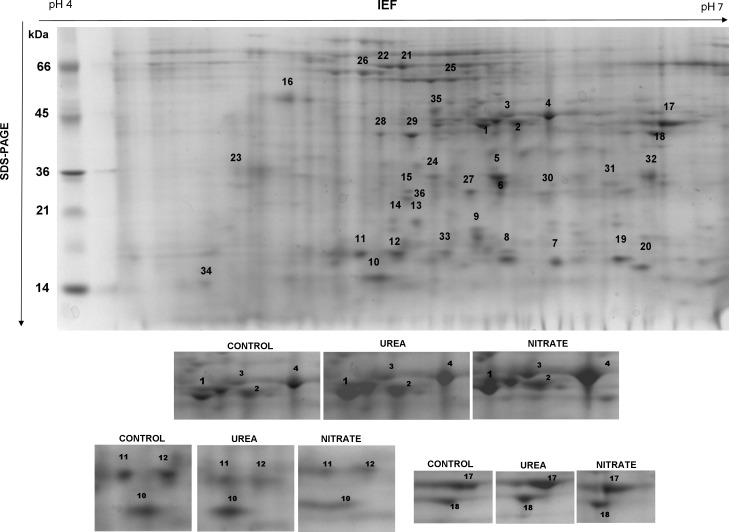
2D-GE pattern of total protein extracted from durum wheat (cv Achille) immature grains.Immature grains—derived from plants fertilized with urea (UREA) and calcium nitrate (NITRATE) at the rate of 150 kg N ha-1 plus unfertilized CONTROL—were sampled at DC75 phenological stage corresponding to 15 DPA and 13 DPA in 2011 and 2012 and total protein extracts were analysed by 2D-GE. The marked spots were analysed by ESI-LC-MS/MS for protein identification. The enlargement illustrates some of the spots showing differential abundance between CONTROL and UREA and NITRATE fertilized treatments.